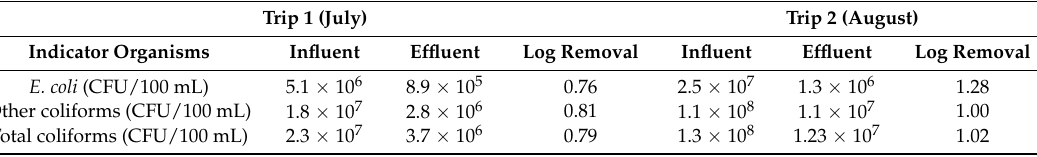
Table 2. Concentrations of indicator organisms in the influent and effluent of the Pond Inlet WSP.